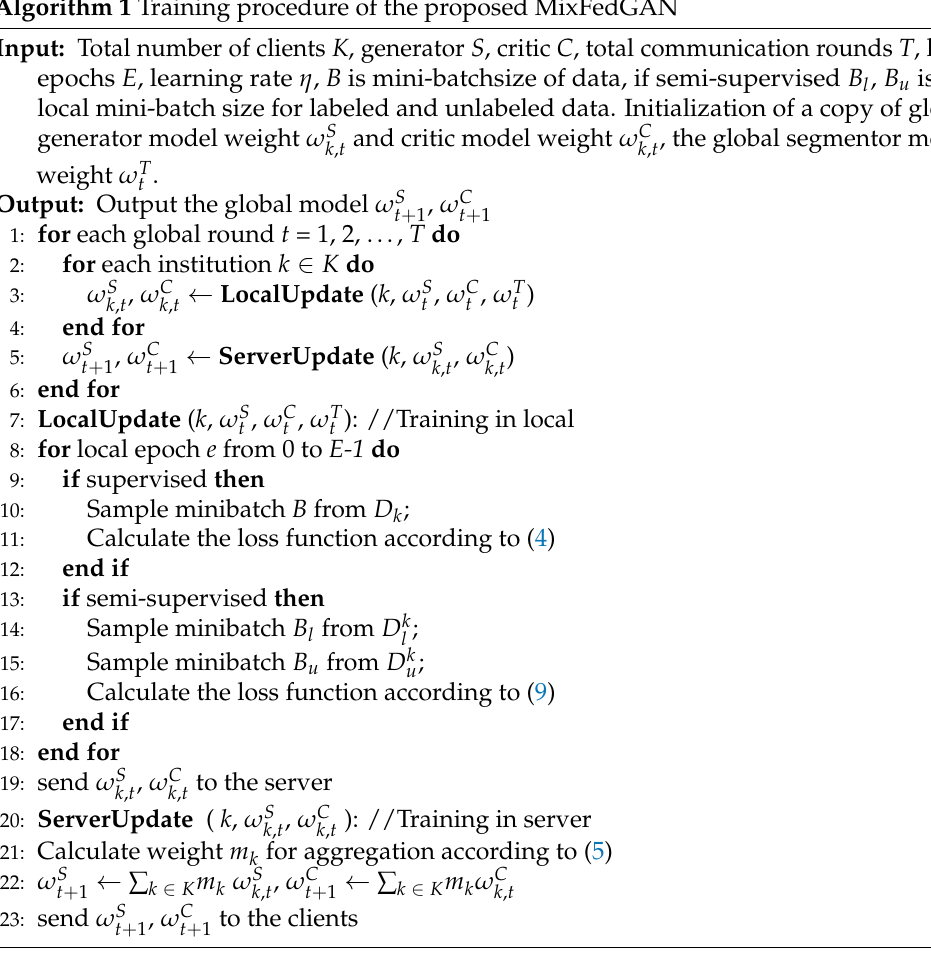
Algorithm 1 Training procedure of the proposed